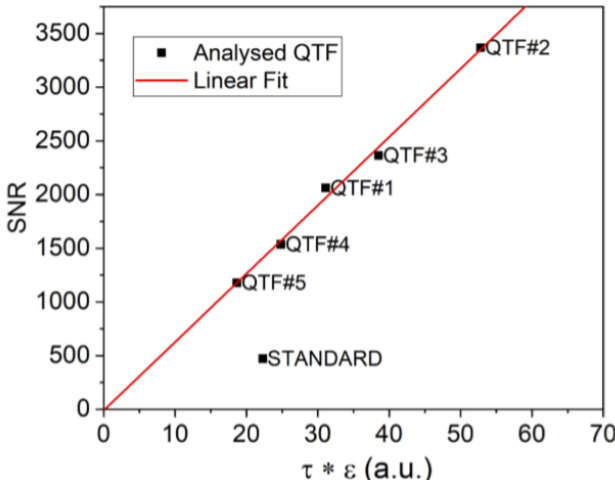
Figure 10. Calculated SNR as a function of the product between accumulation time and strain for all the QTFs analysed (black squares). Linear fit of the results (red line). Reprinted/adapted with permission from Ref. [127]. Copyright 2020, copyright The Optical